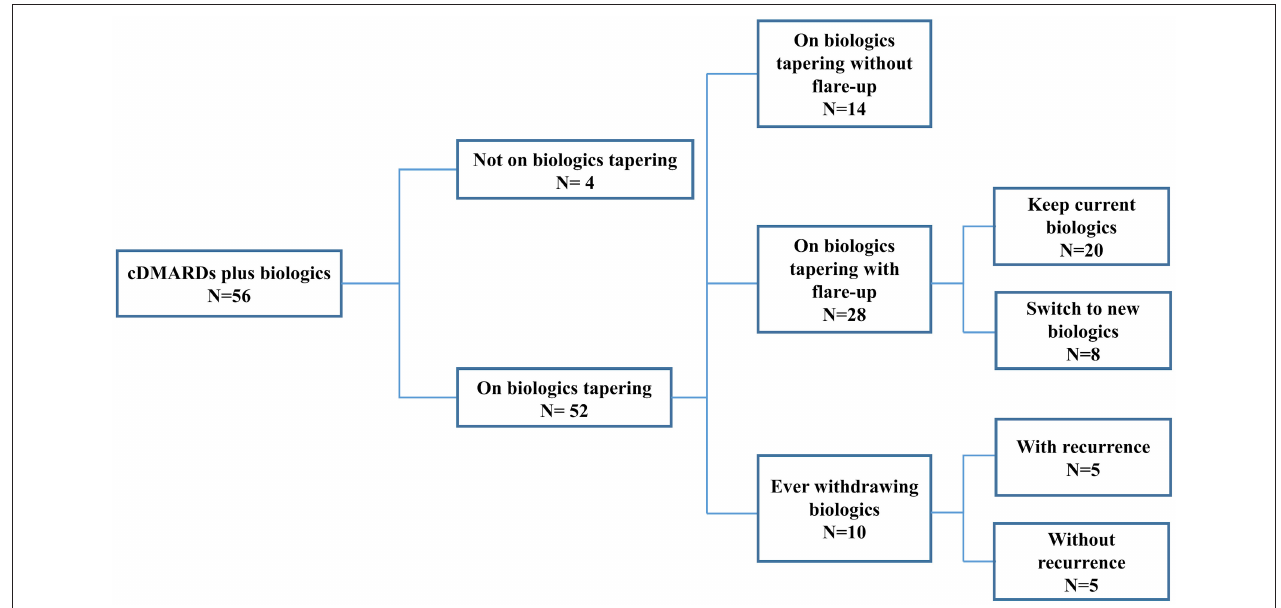
FIGURE 1 | ERA patients stratified by biologics tapering status. ERA, enthesitis-related arthritis; cDMARDs, conventional disease-modifying antirheumatic